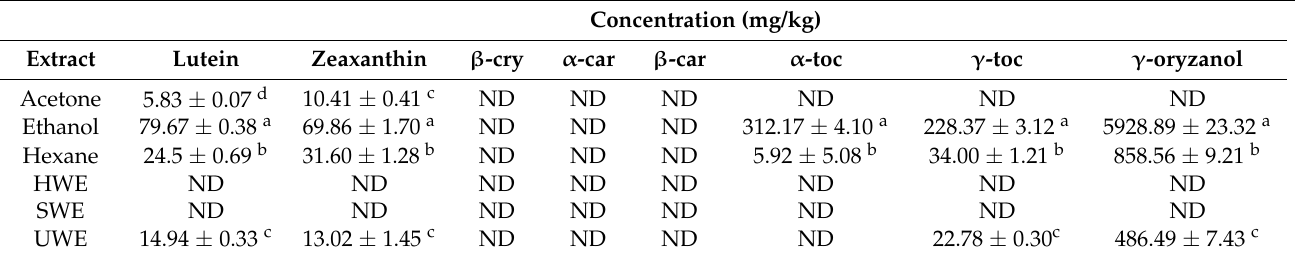
Table 5. Determination of bioactive compounds in wheat germ extracts: carotenoids, tocopherols, and γ